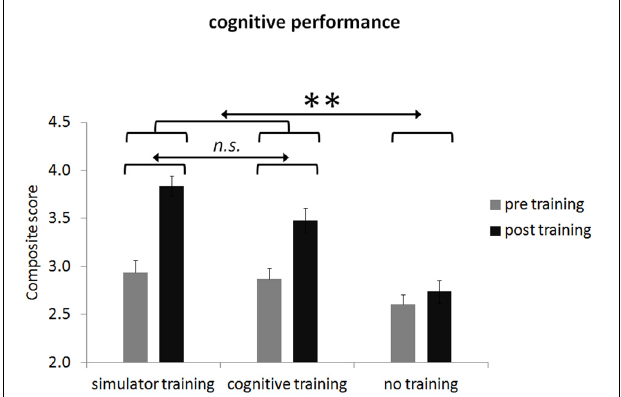
FIGURE 4 | Group means of overall cognitive performance before and after participation broken down for the three groups. Error bars in plots